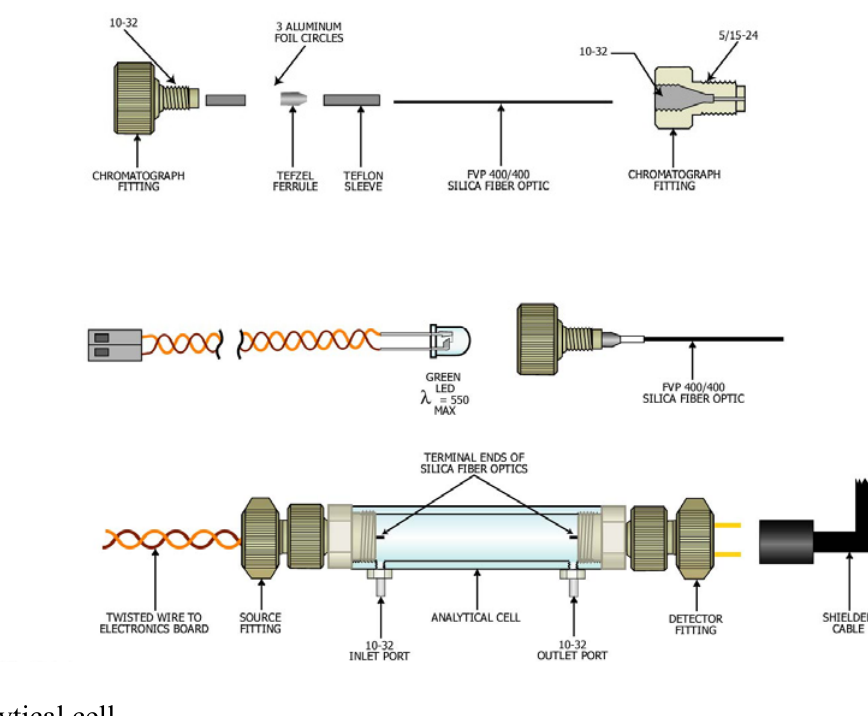
Figure 5. Analytical